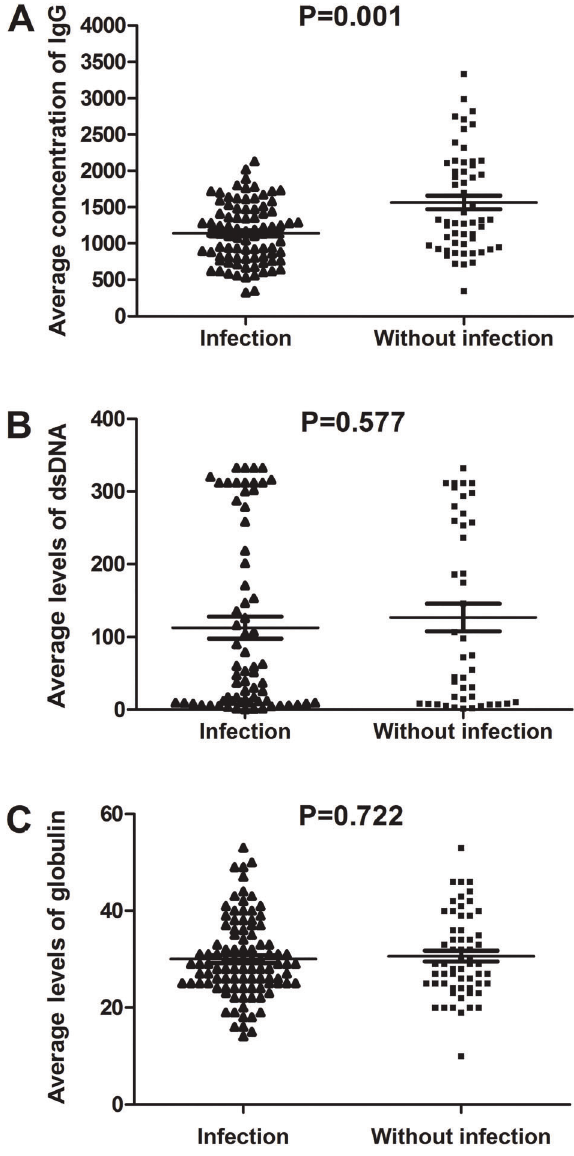
Figure 2. The concentrations of IgG, anti-ds-DNA, and globulin in systemic lupus erythematosus (SLE) patients with or without infection. A , data were obtained from 86 SLE patients with infection and 55 SLE patients without infection. B , 68 SLE patients with infection and 44 SLE patients without infection. C , SLE patients with infection (n=99) and SLE patients without infection (n=59) (Mann-Whitney U or t-test).